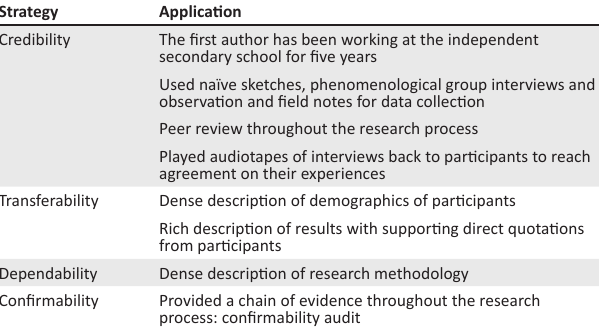
TABLE 1: Strategies to ensure the trustworthiness of the